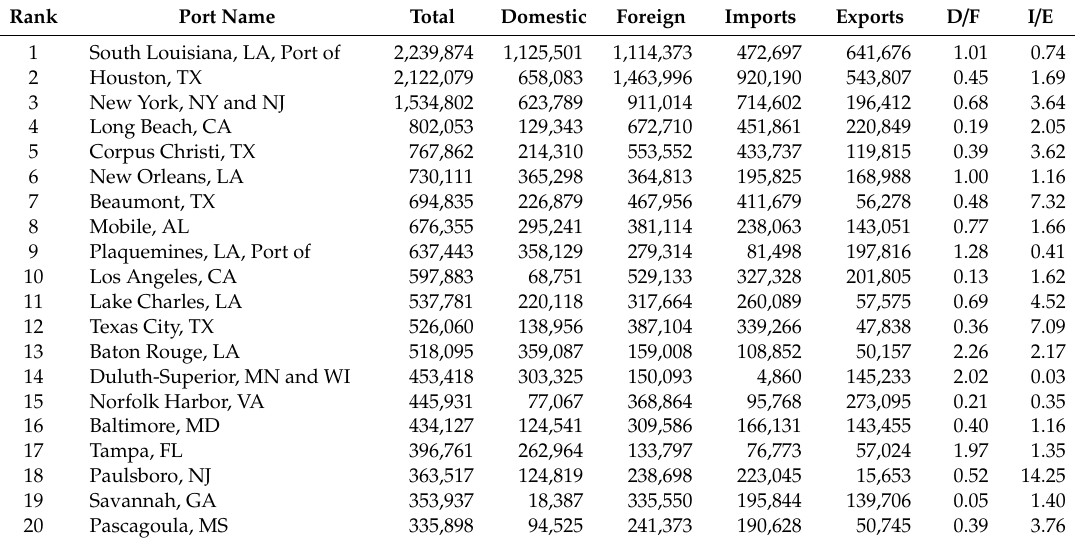
Table 3. Top 20 American ports in imports and exports or other measures (1000 tons),